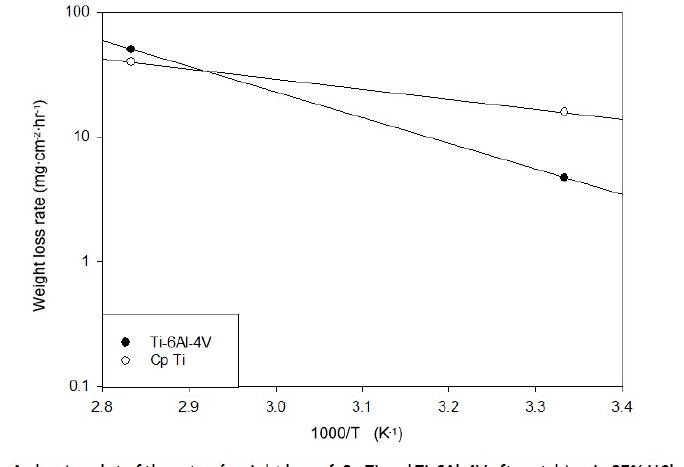
Figure 11. The Arrhenius plot of the etching rate and weight loss of the CP Ti and Ti-6Al-4V after etching in ( a ) H 2 SO 4 ; and ( b ) HCl.